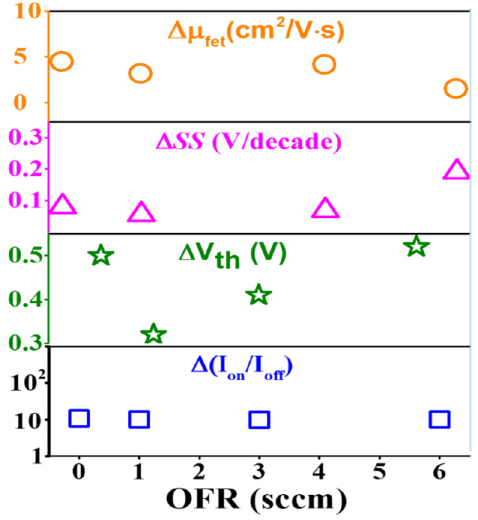
Figure 9. The variation (∆) of each electrical parameter from the lower to higher sizes channel width with the various O 2 flow rates.